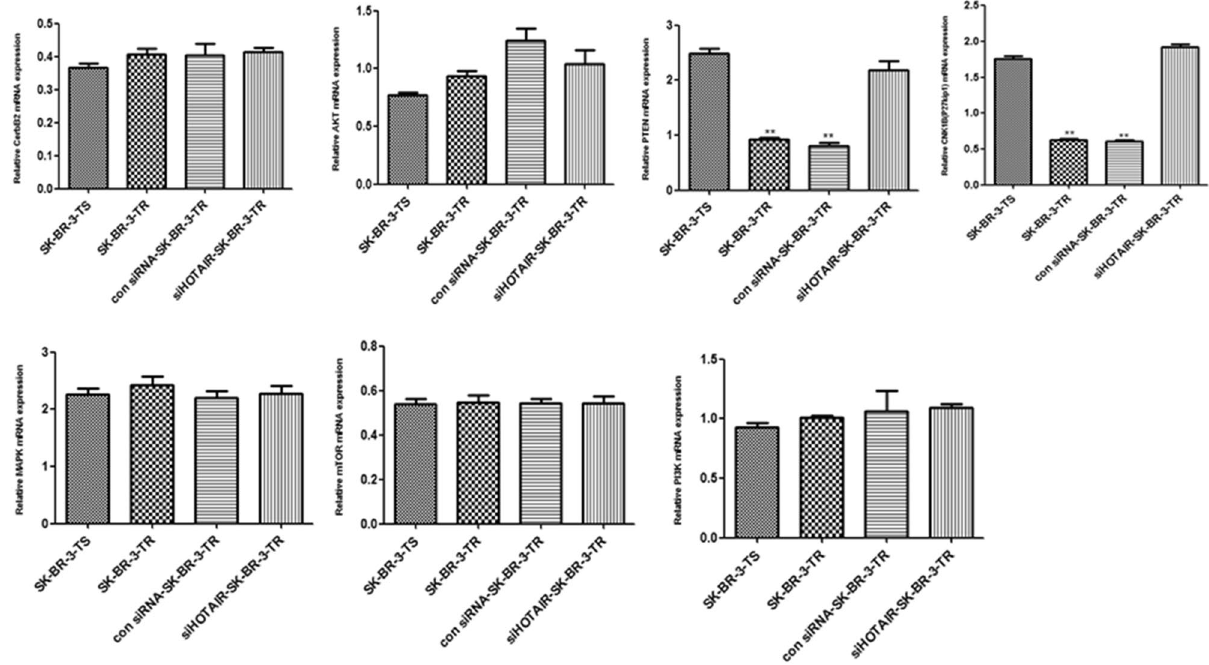
Figure 6. mRNA levels of genes in the PI3K/AKT/mTOR, MEK/MAPK and HER2 receptor pathways following SHOTAIR knockdown. ** P < 0.01 vs